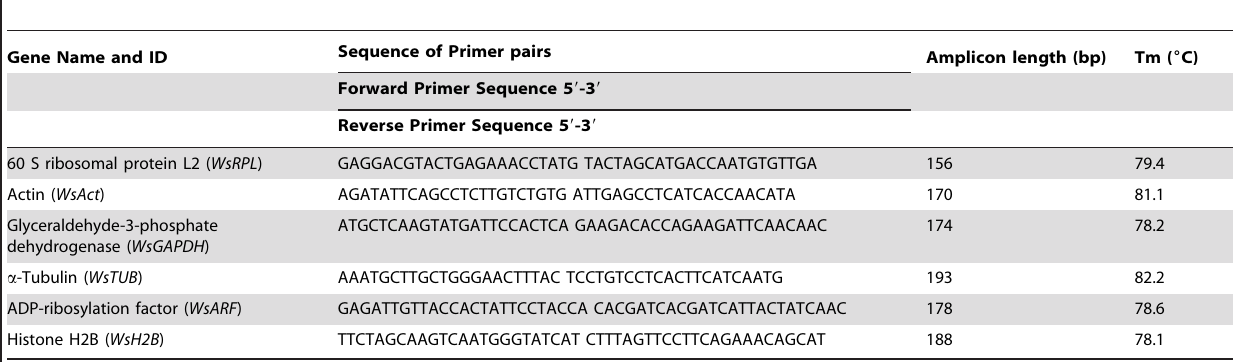
Table 1. Details of primer pairs and amplicon size of reference genes used for normalization of qRT-PCR data in W. somnifera.